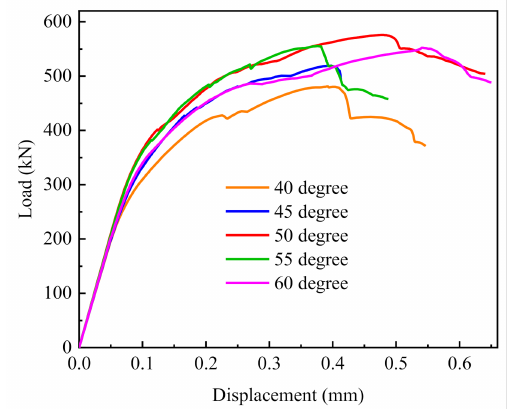
Figure 14. Load–displacement curves of S-SWJ with different shear key angles.